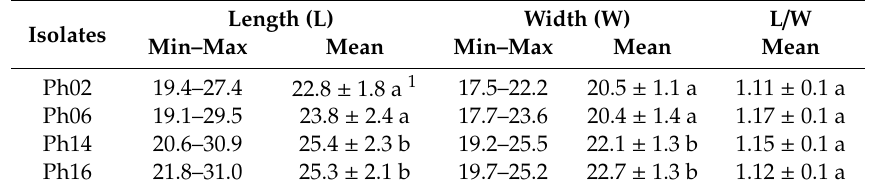
Table 2. Urediniospores dimensions (in µ m) of four Puccinia hemerocallidis isolates collected in Portugal.